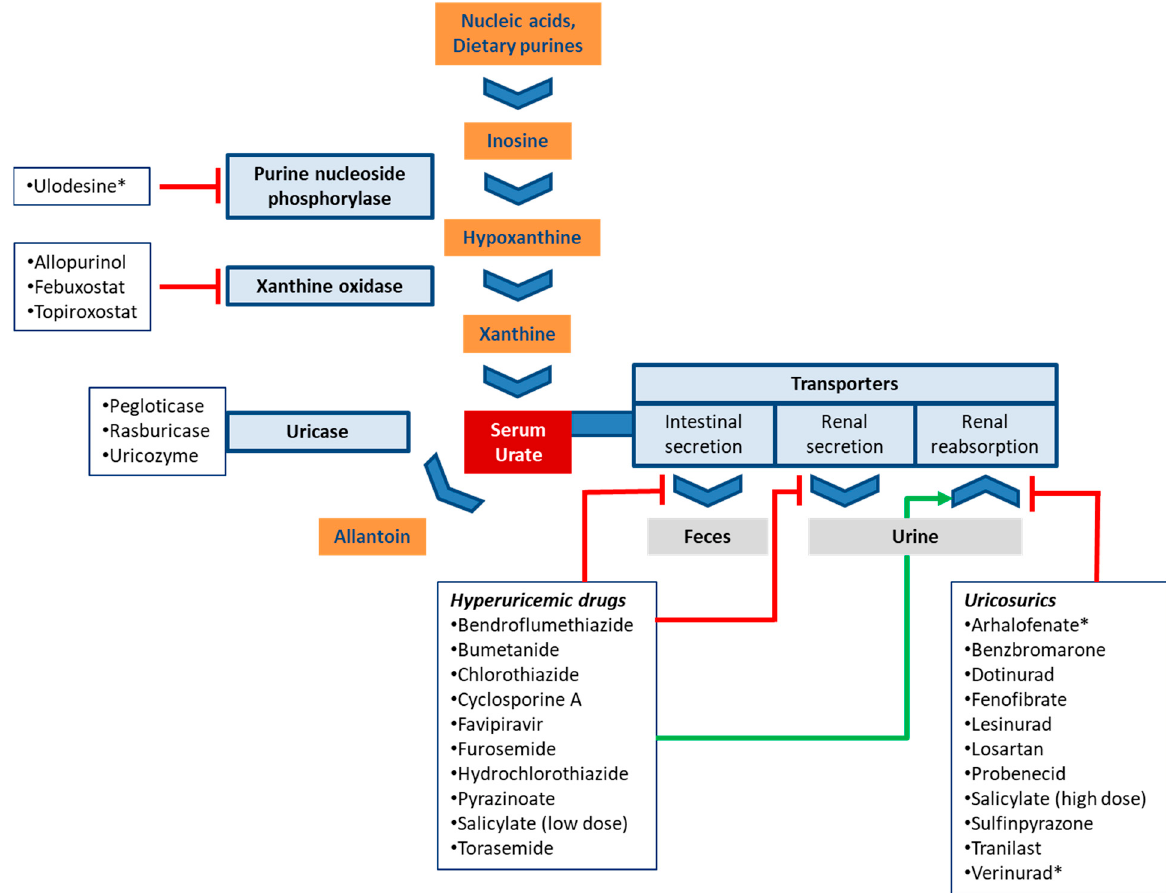
Figure 1. Schematic routes of urate production and disposition. The boxes list drugs that affect urate homeostasis and are discussed in this review. Experimental drugs are marked with an asterisk (*). Red bars (inhibition) and the green arrow (stimulation) indicate the main mechanism by which drugs modulate serum urate levels.